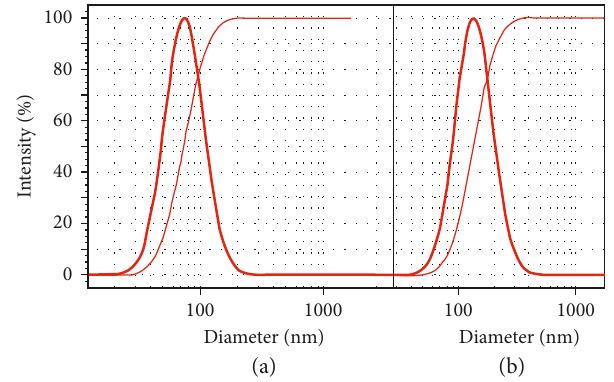
Figure 2: DLS profiles of optimum nanoemulsions containing EOs of (a) F. vulgare